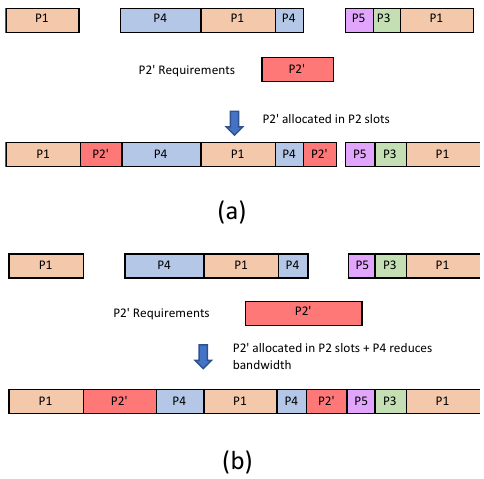
Figure 5. Two scenarios of changes in P2 requirements: ( a ) P2′ requirements are enough to be allocated in P2 slots. ( b ) P2′ requirements need also that P4 reduces its allocation.